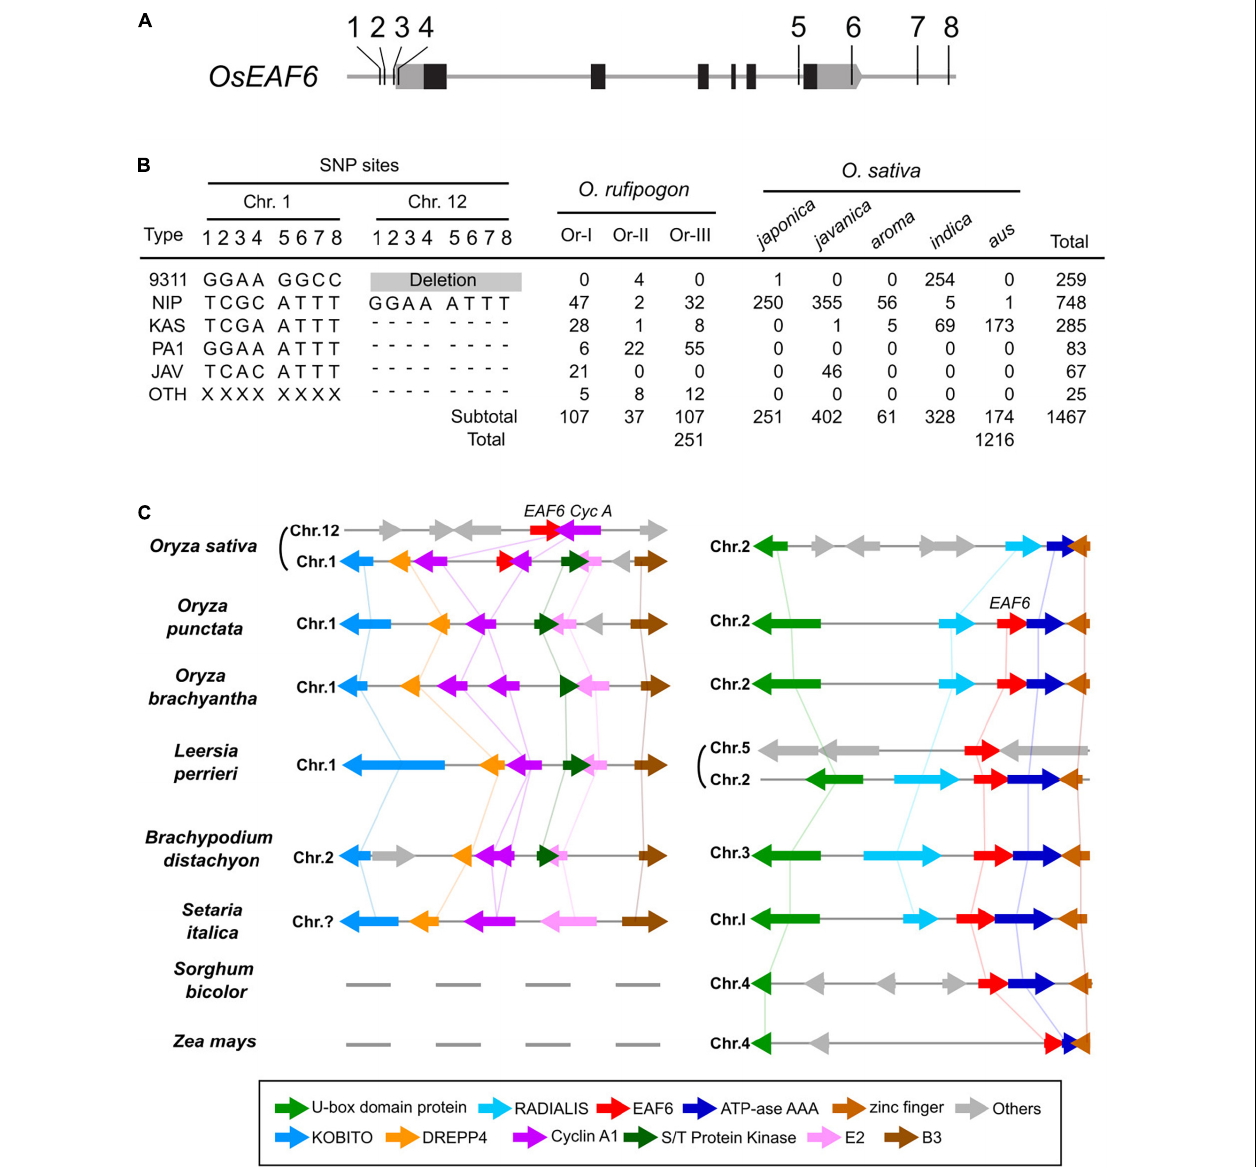
chromosome 12 in a subpopulation of O. rufipogon ; and